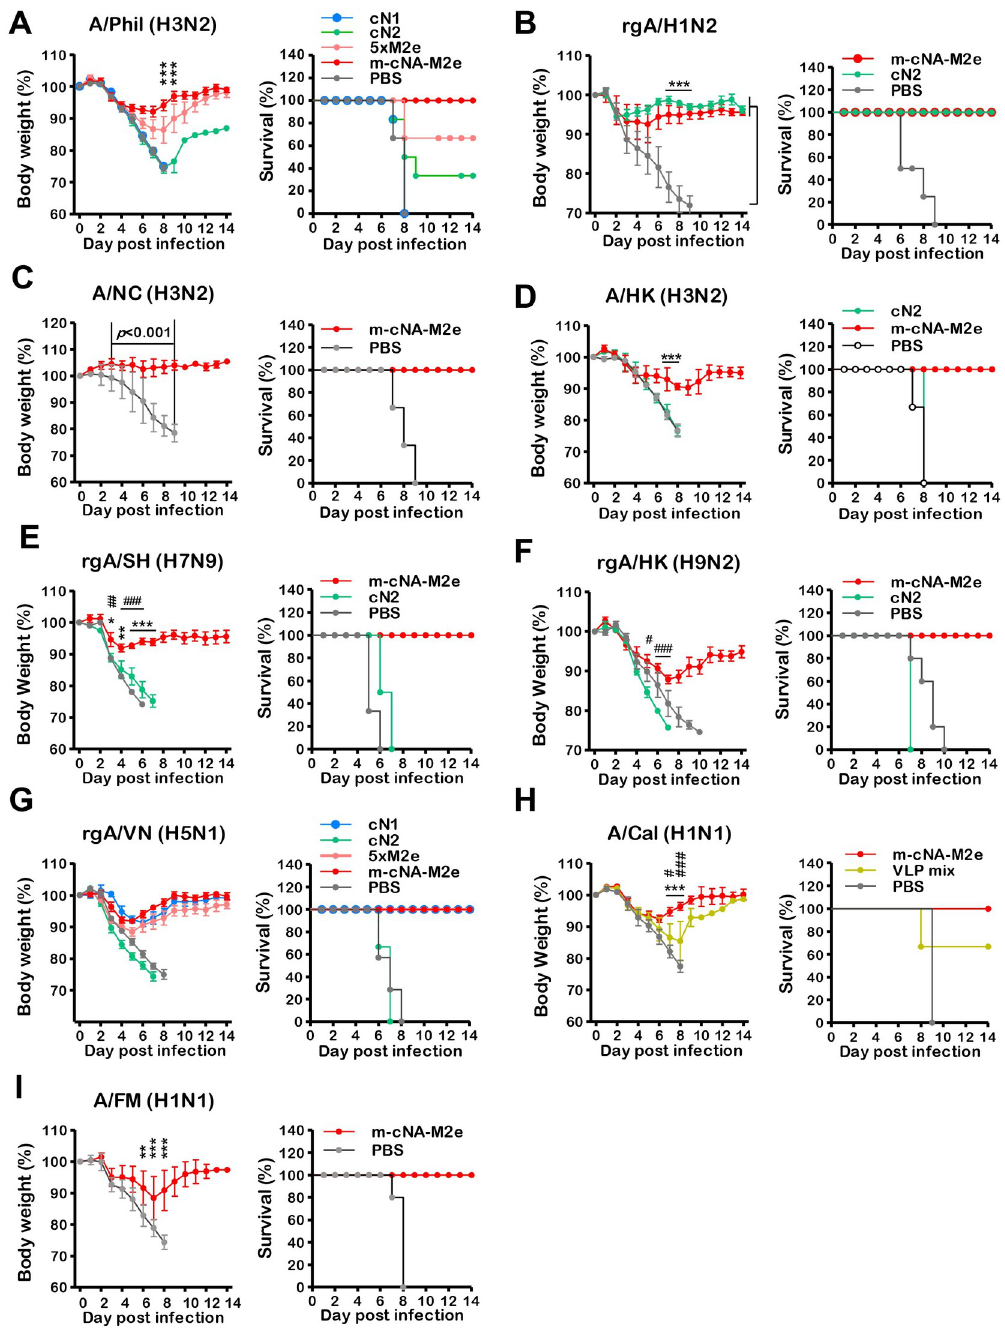
Fig 3. Broad cross protection against different NA subtype influenza A viruses after vaccination. Immunized mice (n = 6 per group) were infected with a lethal dose of different NA subtype influenza A viruses. (A) A/Phil/1982 (H3N2) (3xLD 50 , 2.3x10 2 EID 50 ), (B) rgA/H1N2 (3xLD 50 , 1.3x10 3 EID 50 ), (C) A/NC (H3N2) (A/Nanchang/1995, 2xLD50, 3x10 6 EID 50 ), (D) A/ HK H3N2 (5xLD 50 , 4x10 EID 50 ), (E) rgA/SH/2013 (H7N9) (3xLD 50 , 1.1x10 4 EID 50 ), (F) rgA/HK/1999 (H9N2) (5xLD 50 , 1.4x10 2 EID 50 ), (G) rgA/VN/2004 H5N1 (3xLD 50 , 2.6x10 4 EID 50 ), (H) A/Cal/2009 H1N1 (3xLD 50 , 2x10 3 EID 50 ), (I) A/FM/ 1947 H1N1 (3xLD 50 , 8x10 3 EID 50 ). The VLP vaccine dose and groups are the same as in the Fig 2 legend except for the cN2 (cN2 VLP, 10 μ g) group in ( B) . The statistical significances were performed with one-way ANOVA with Tukey’s Multiple Comparison test and indicated as � ,# P < 0.05; �� ,## , P < 0.01; ��� ,### , P < 0.001 (compared among the m-cNA-M2e and PBS, monomeric cN, or VLP mix control groups); ns, no significant difference between two compared groups.